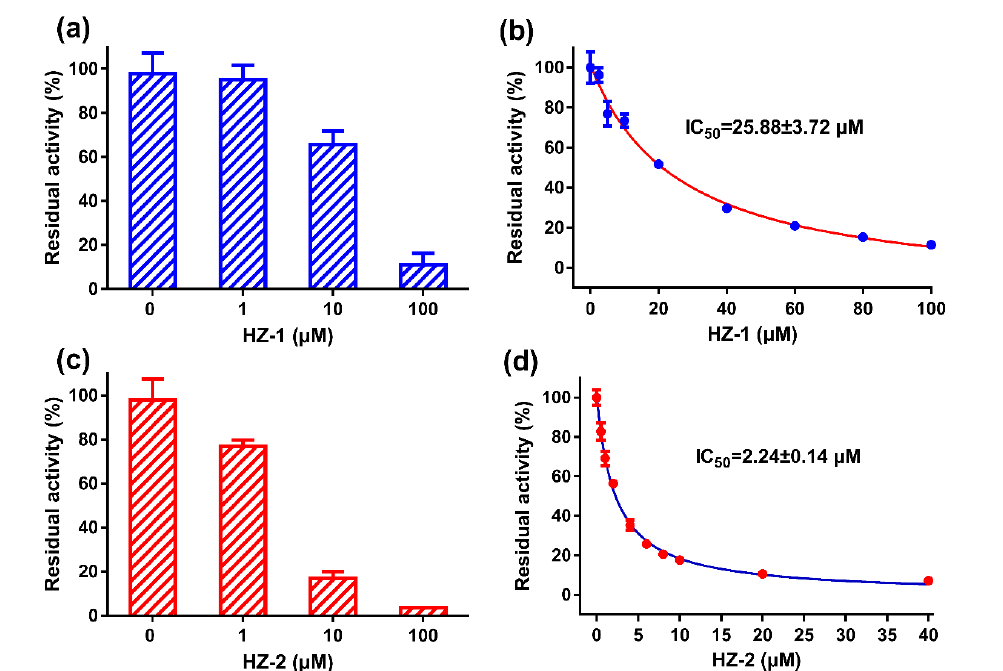
FIGURE 3 - (a) Inhibitory effects of HZ-1 and HZ-2 at the concentrations of 0, 1, 10, 100 μg/mL on EcGUS-mediated DDAOG hydrolysis, and (b) the concentration dependent inhibition of EcGUS-catalyzed DDAOG hydrolysis by HZ-1 and HZ-2 . Each data point corresponds to the average values calculated from triplicate